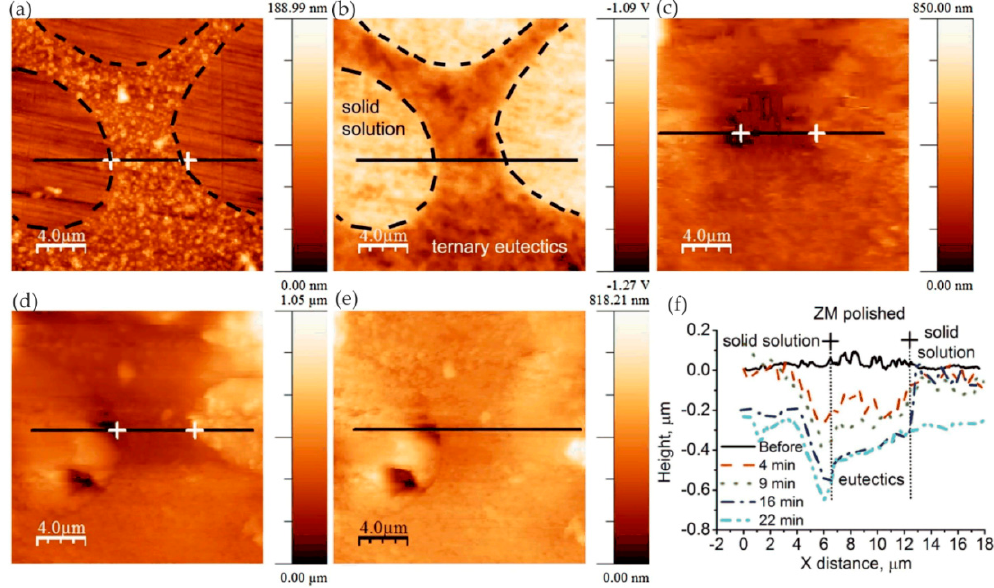
Figure 22. AFM topography ( a ) and SKPFM ( b ) maps of Zn–Al–Mg (ZM) galvanized coating before immersion and during immersion in 0.005 M NaCl for 4 min ( c ), 9 min ( d ), and 22 min ( e ). ( f ) Evolution of topography across the black line profiles. Reprinted with permission from Reference [56]; copyright 2016 Elsevier Ltd.